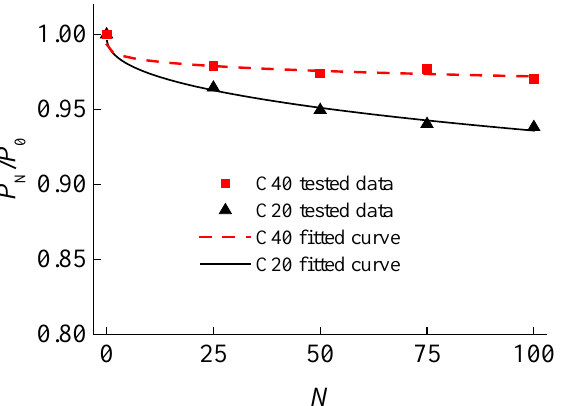
Figure 9. Relationship between normalized relative dynamic elastic modulus and N .